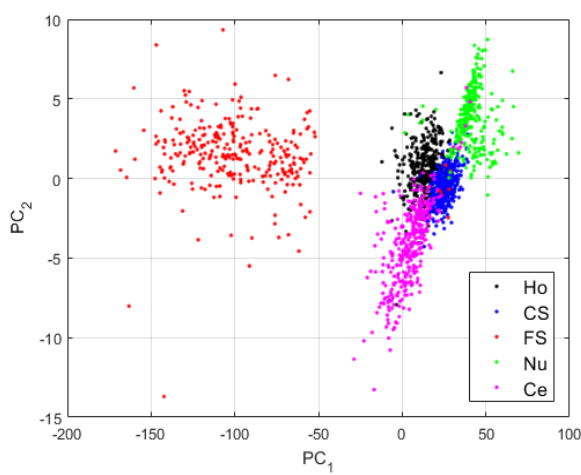
Figure 6. Visualization of the features learned by the DCAE in case ‐ 1. “Ho”, “CS”, “FS”, “Nu”, and “Ce” represent the homogeneous, the coarse speckled, the fine speckled, the nucleolar and the centromere cells, respectively. The percentages of the variance explained are, respectively, 99.23% and 0.42% for the first and second principal components.